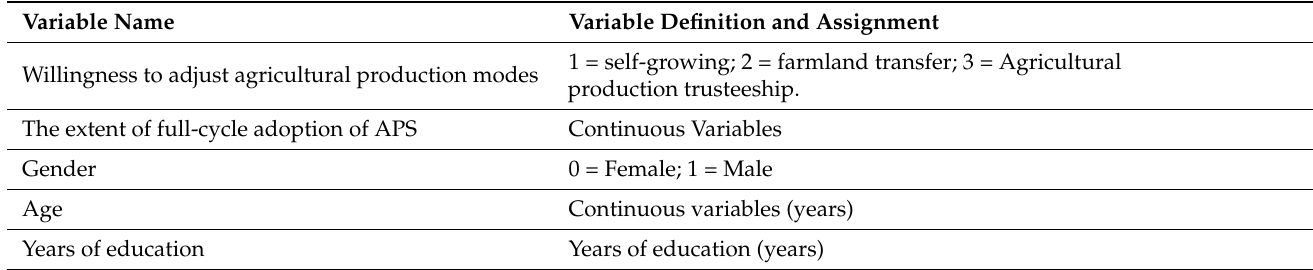
Table 1. Specific definitions and assignments of the main variables of each